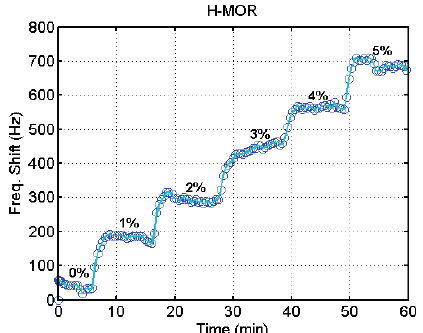
Figure 5. Temporal variation of frequency shift of the H-MOR coated QCM at different water